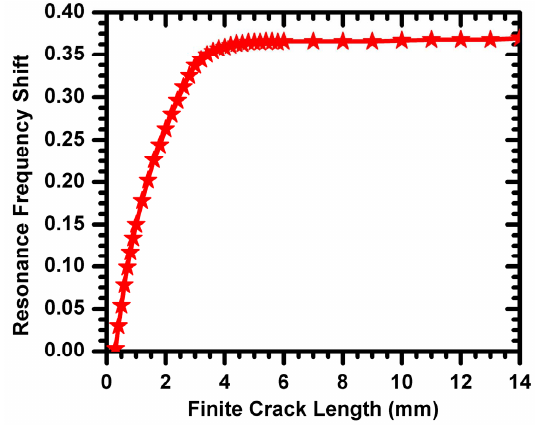
Figure 8. Resonance frequency shift as a function of the crack length. The crack is 0.2 mm wide and 2 mm deep.